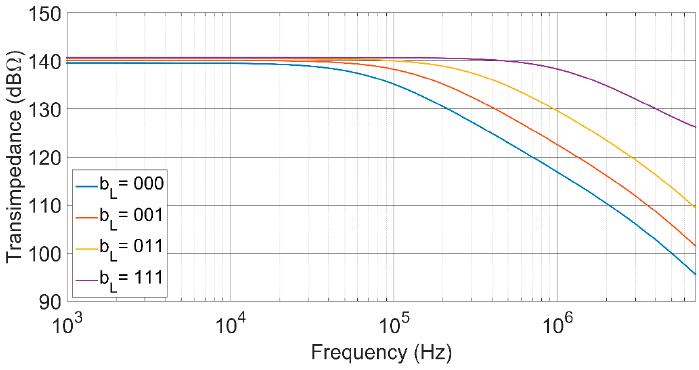
Figure 7. Frequency response showing the transimpedance gain programmability with a double control of the feedback resistor and the open loop gain. The bandwidth is almost constant at 1.2 MHz.